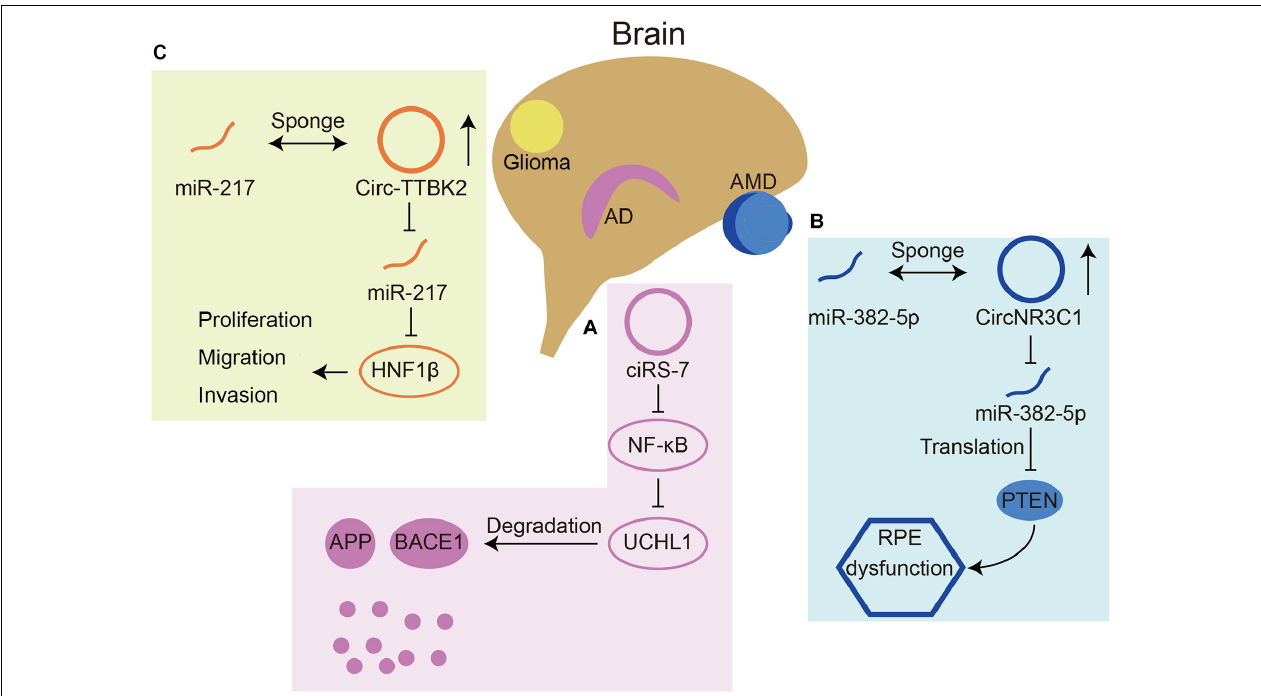
FIGURE 4 | Three circRNAs that play roles in neurological diseases. (A) CiRS-7(also named circCDR1as) can inhibit translation of NF- κ B, resulting in upregulated expression of UCHL1. UCHL1 can promote the degradation of APP and BACE1 in AD. (B) CircNR3C1 acts as a miR-382-5p sponge, which can inhibit translation of an AMD related gene PTEN. (C) Circ-TTBK2 acts as a miR-217 sponge, which can inhibit HNF1 β . HNF1 β can promote glioma